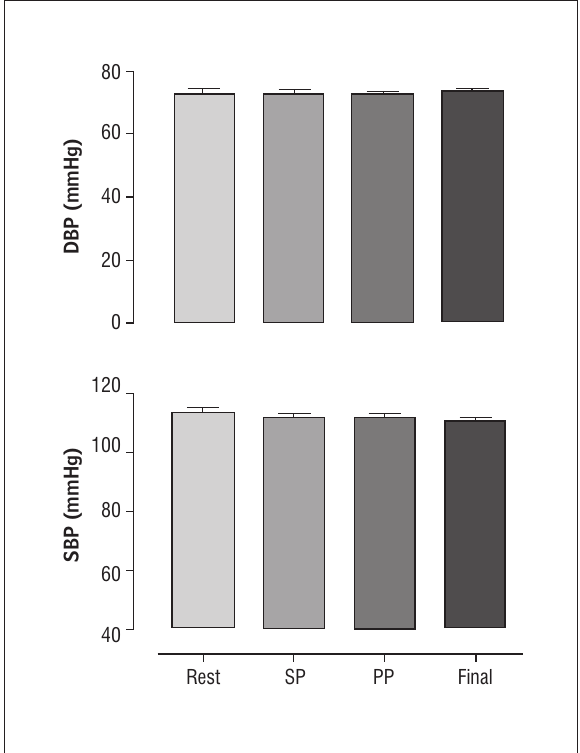
Figure 1 - Behavior of the systolic and diastolic blood pres- sure before, during and immediately after MLD Note: Systolic blood pressure (SBP); diastolic blood pressure (DBP); supine position (SP); prone position (PP).